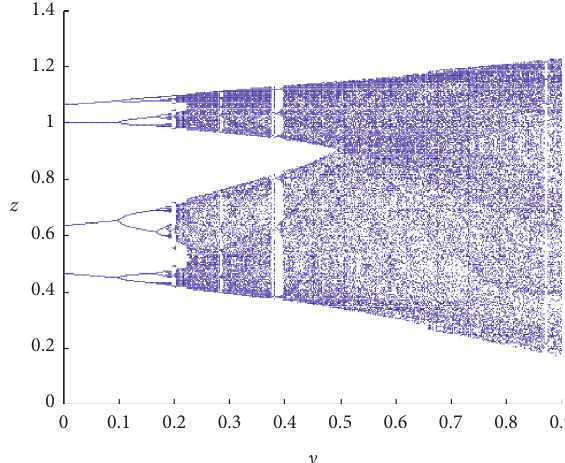
Figure 17: x – y phase diagram which denotes that the system is chaotic when β � 3.